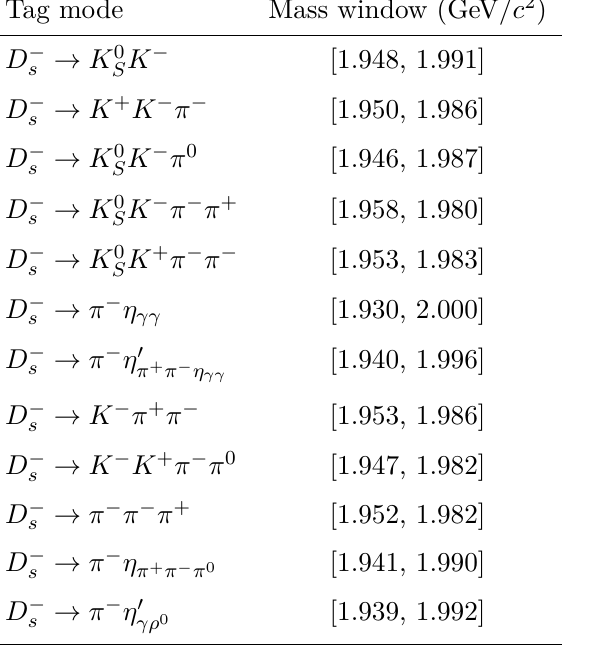
Table 3 . Requirements on the tagging D − subscripts denote the decay modes used to reconstruct these